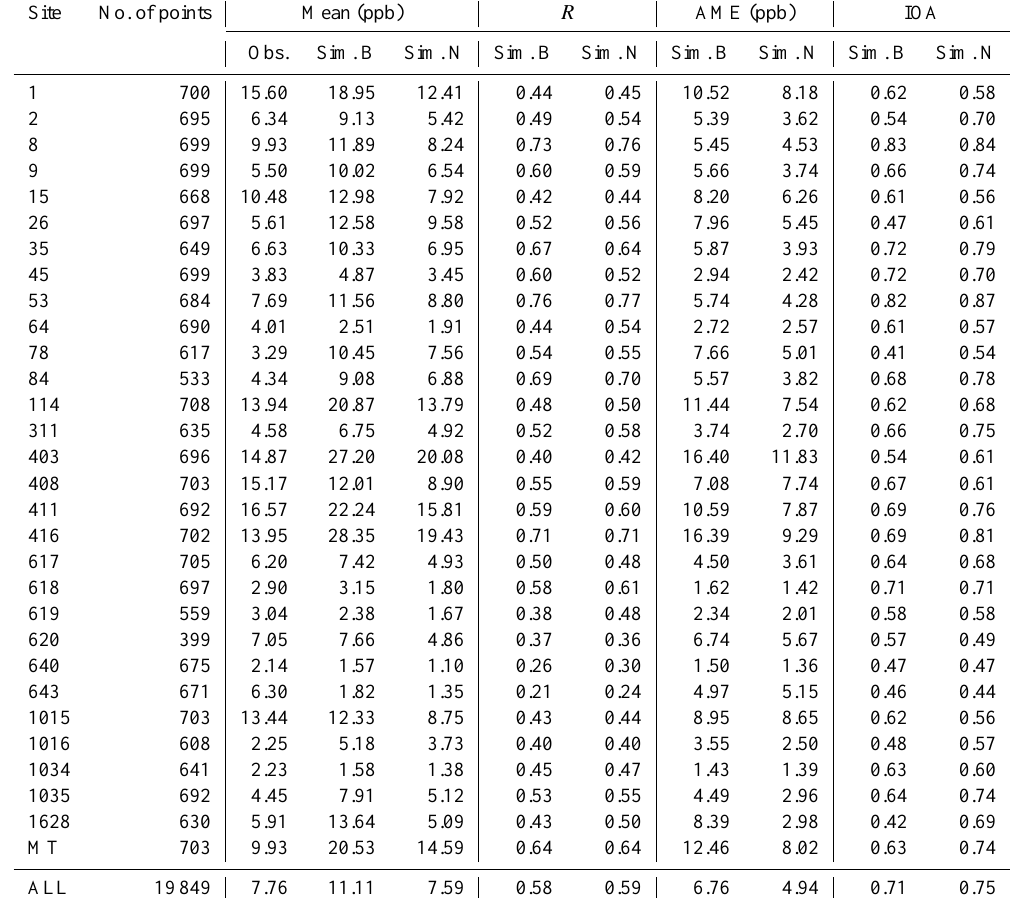
Table 2. Summary of statistical parameters for the base case simulation (B) and reduced NO x case (N).